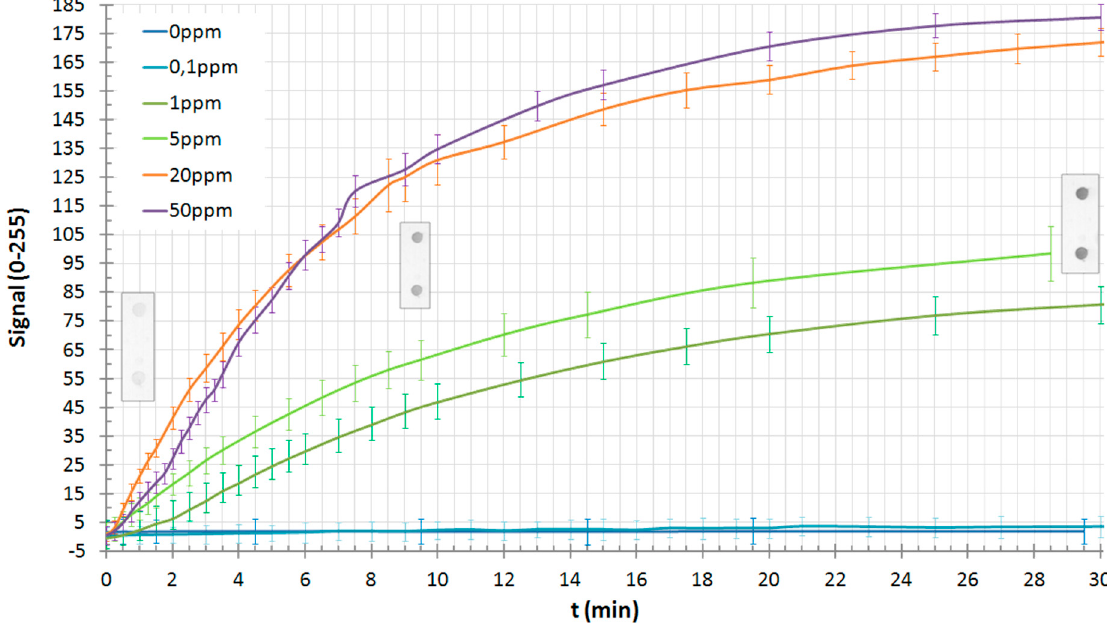
Figure 6. Gluten concentration signal versus developing